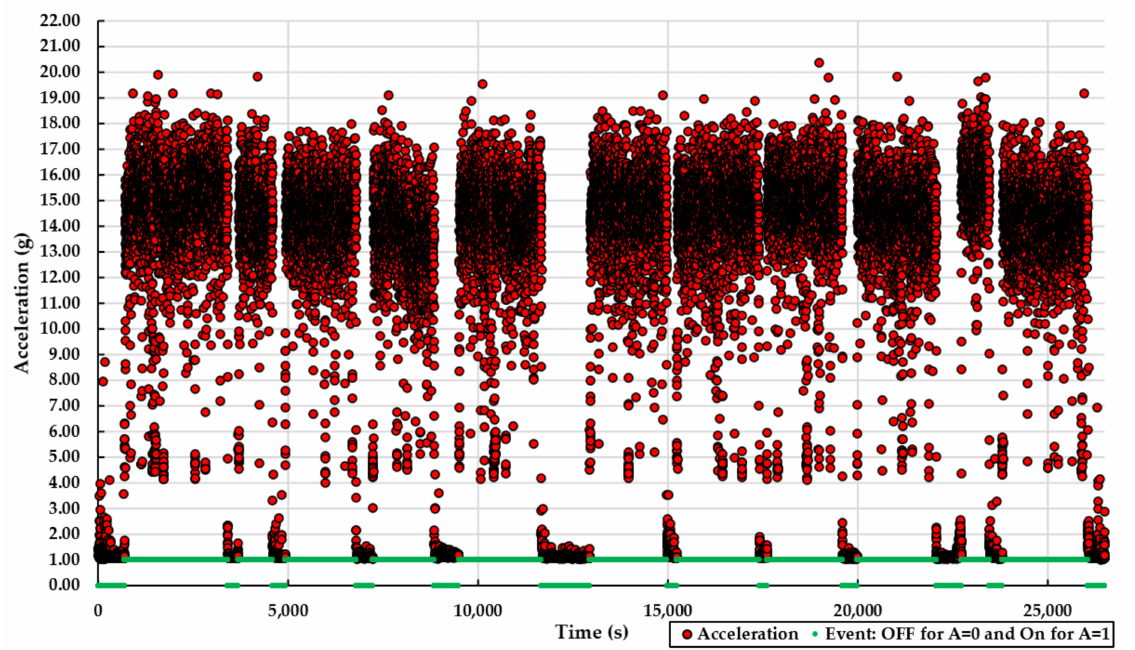
Figure A2. Description of datasets used in the testing phase of the MLPs: TEST_E1. Note: conventionally, a value set at 0 (A = 0) indicates the events documented as OFF, while a value set at 1 (A = 1) indicates the events documented as ON.